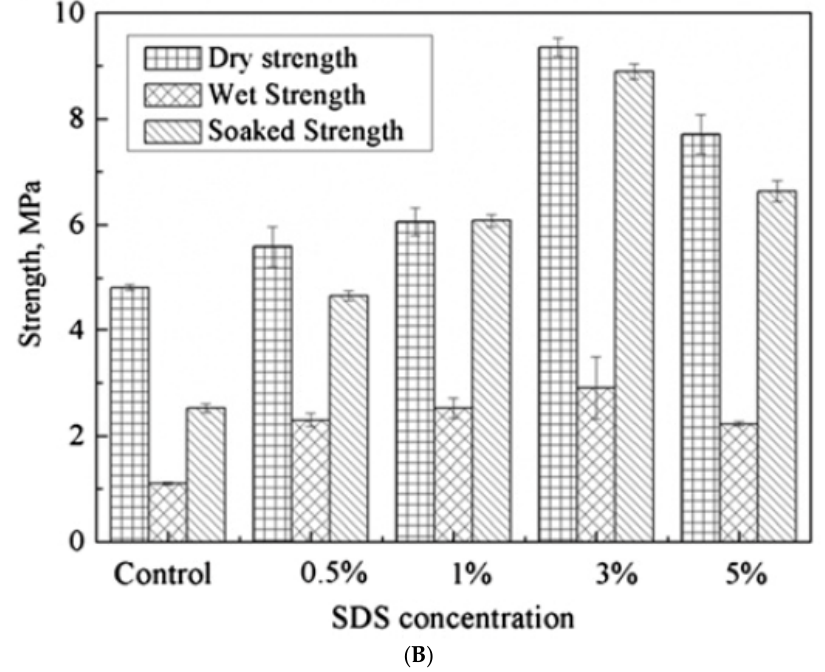
Figure 3. Effect of: urea concentration ( A ); and SDS amount ( B ) on the adhesive strength of modified spent hen protein. Curing conditions: time = 4 min; temperature = 110 °C; pressure = 3.5 MPa. Figure adopted with copyright permission from Elsevier (for Wang and Wu, 2012).